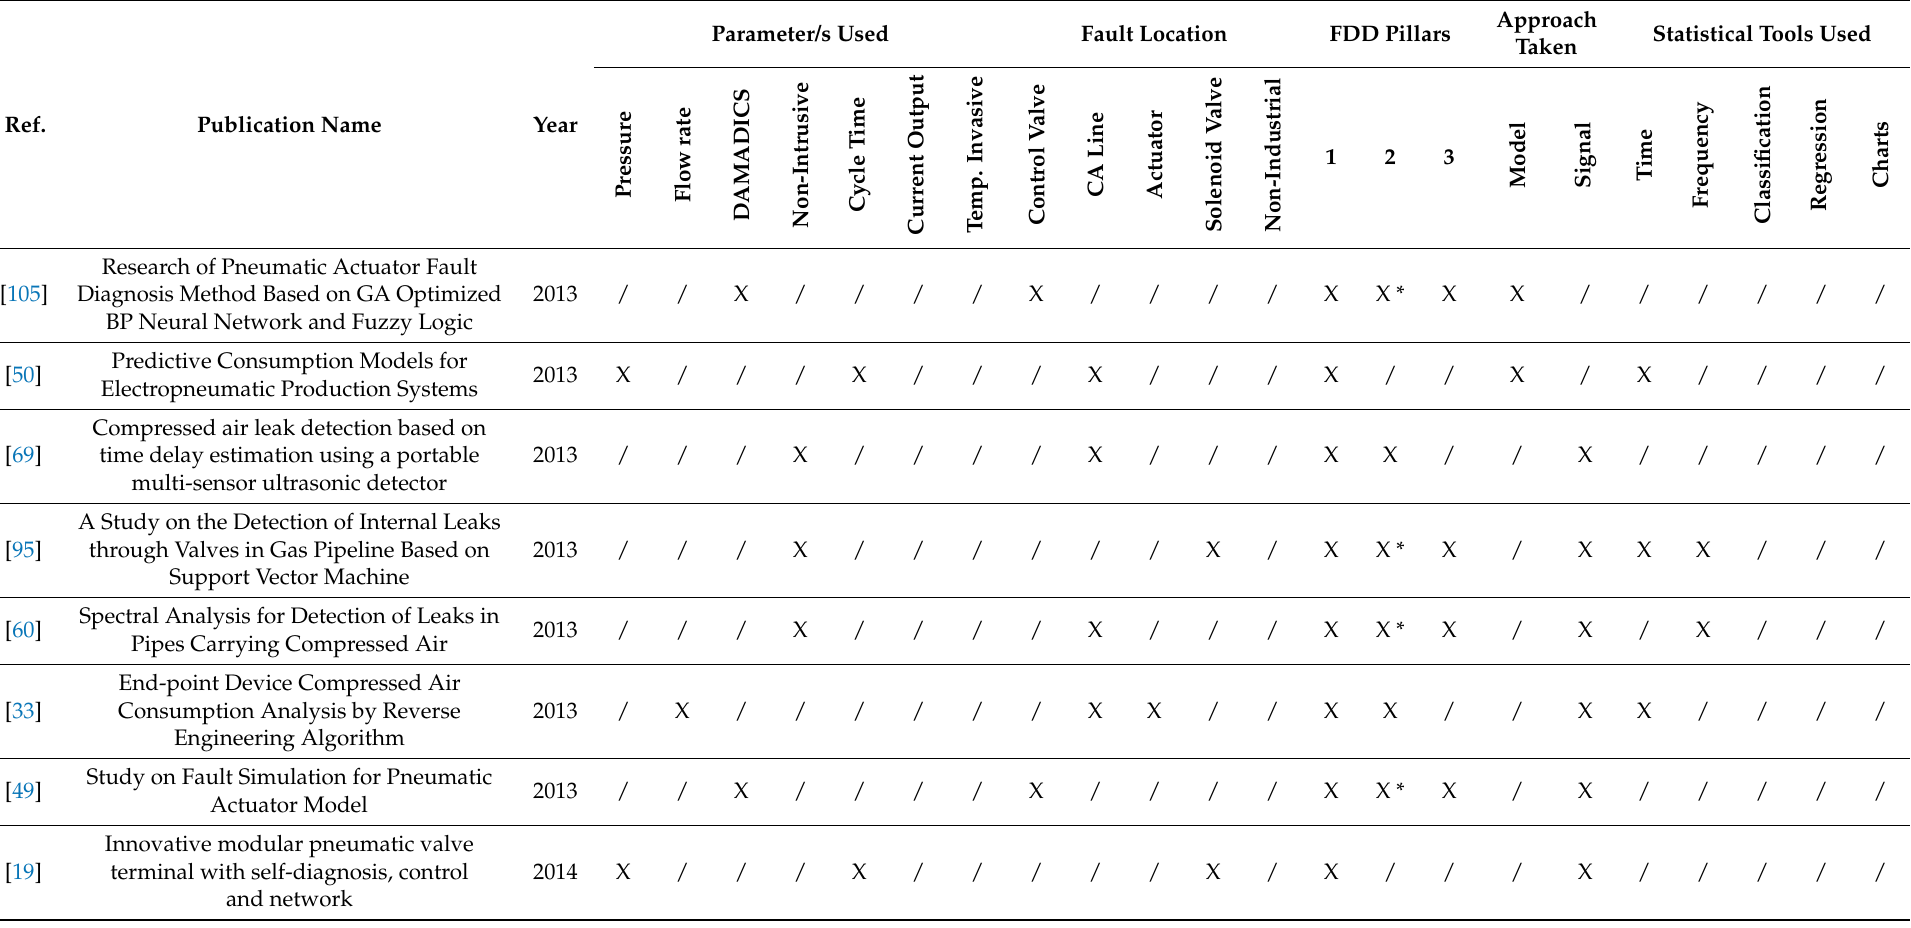
Table A1. Classification of studies according to their